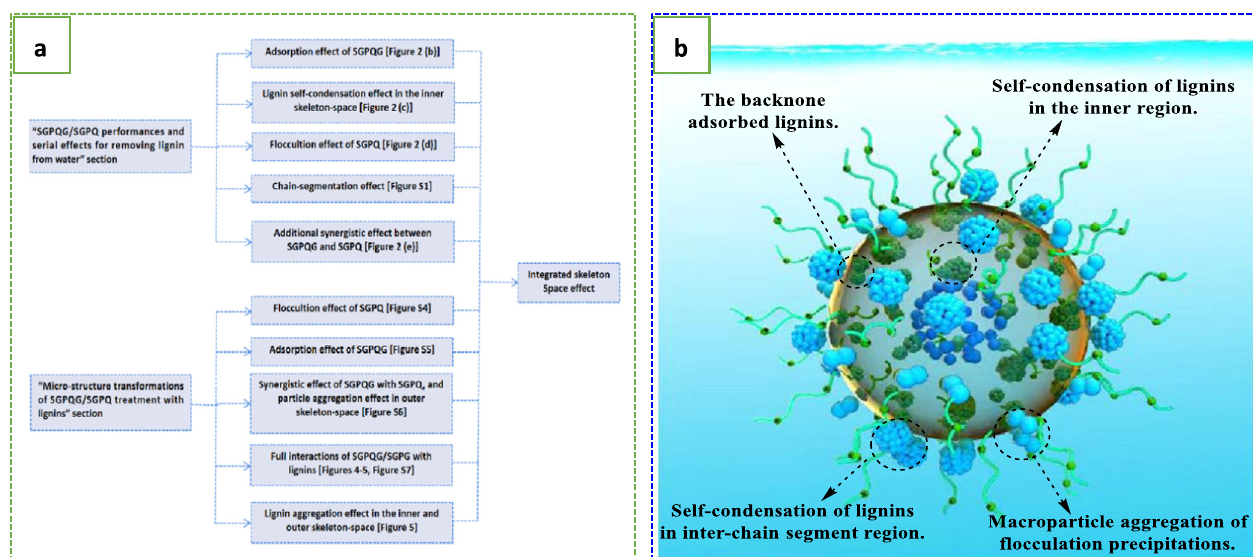
Fig. 6 Constructing effect mechanism model of SGPQG/SGPQ for removing lignins in water. a Logic derivation diagram. b Interaction mechanism model image for SGPQG/SGPQ treatment with